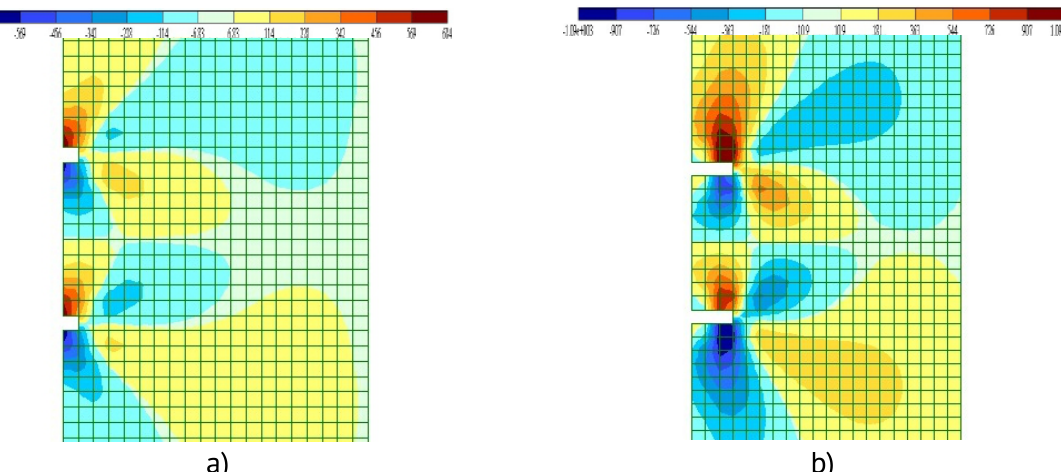
in the area with structural defect: defect depth 5 mm (а) and 15 Figure 6. Stress fields τ xy mm (b) for concrete grade С20/25 under stress in concrete